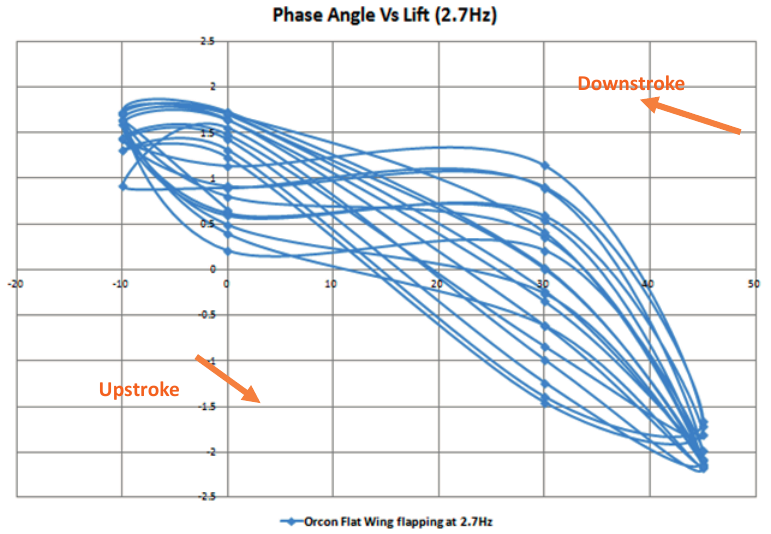
Figure 45. Phase angle vs. lift for Orcon flat wing flapping at 2.7 Hz.